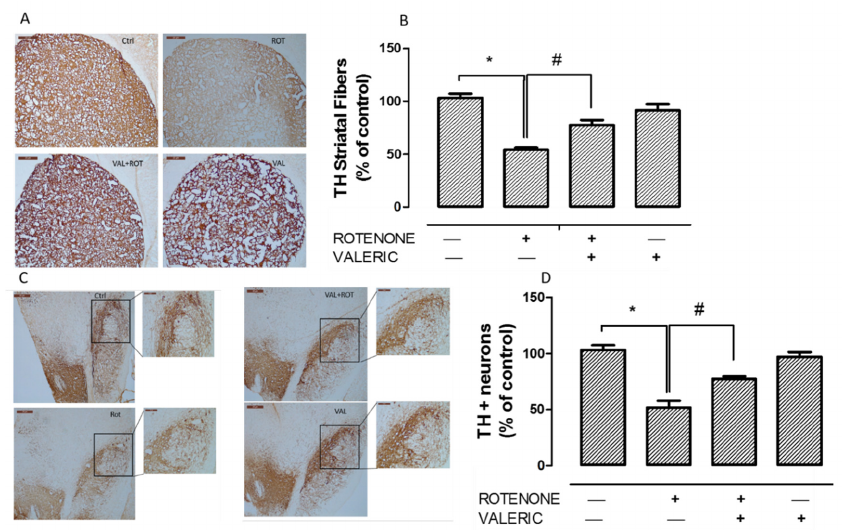
Figure 4. Valeric acid attenuated rotenone induced dopaminergic neurodegeneration. Immunohistochemistry of 20 µm coronal sections with anti-tyrosine hydrolase antibody of striatum ( A ) and substantia nigra ( B ) of experimental animals. Densitometric analysis of tyrosine hydrolase positive neuronal fibers ( C ) and tyrosine hydrolase positive neurons ( D ) were performed using Image J. Administration of rotenone cause a significant reduction in both TH+ve neuronal fibers and neurons in striatum and substantia nigra respectively. Whereas, administration of Val prevented this loss significantly. Values are expressed as mean ±SEM. * p < 0.05 compared to control, # p < 0.05 compared to rotenone treated group.